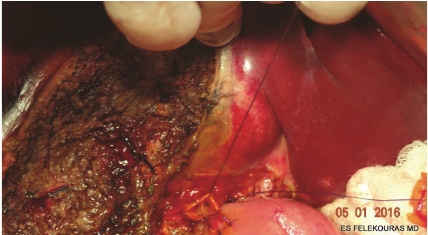
Figure 1: Dissection and division of the extrahepatic bile duct to the level of the biliary confluence of the right and left hepatic ducts at the hilum. Stay sutures with atraumatic needle placed in the stumps of each hepatic duct. The mucosa of the jejunal limb orifice is slightly inverted, using four PDS 5-0 interrupted sutures. Note that the circumference of the duct is 2𝜋𝑟 = 21.997 , so the bites have to be 2𝜋𝑟/4 = 21.997/4 = 5,4 mm. So this anastomosis can be done with 6 stiches (assuming you put your stiches with a step of